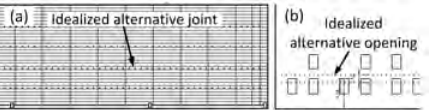
Figure 9. (a) Idealization of the joints and (b) ideal- ization of the